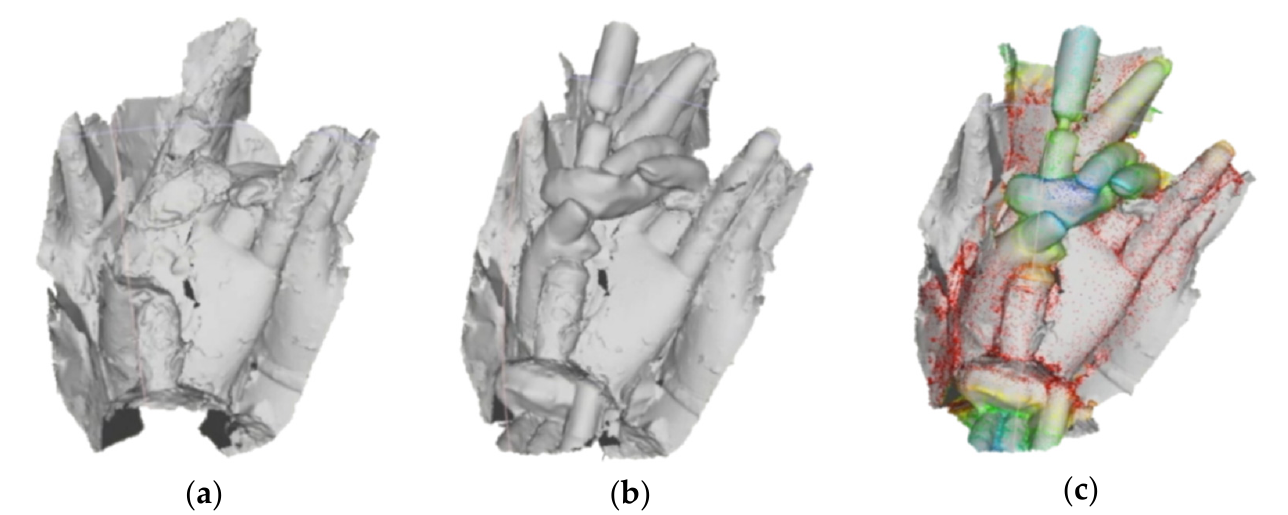
Figure 10. ( a ) Three-dimensional mesh model of the damaged status; ( b ) geometric shape after virtual restoration; ( c ) comparison results of before and after restoration; the colors from red to blue represent the degree of geometric change.